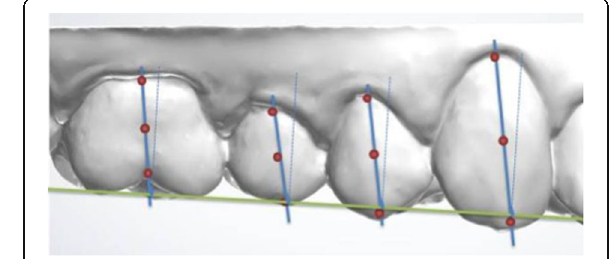
Fig. 3 Mesiodistal tipping: mesiodistal inclination of the FACC with respect to the occlusal plane of